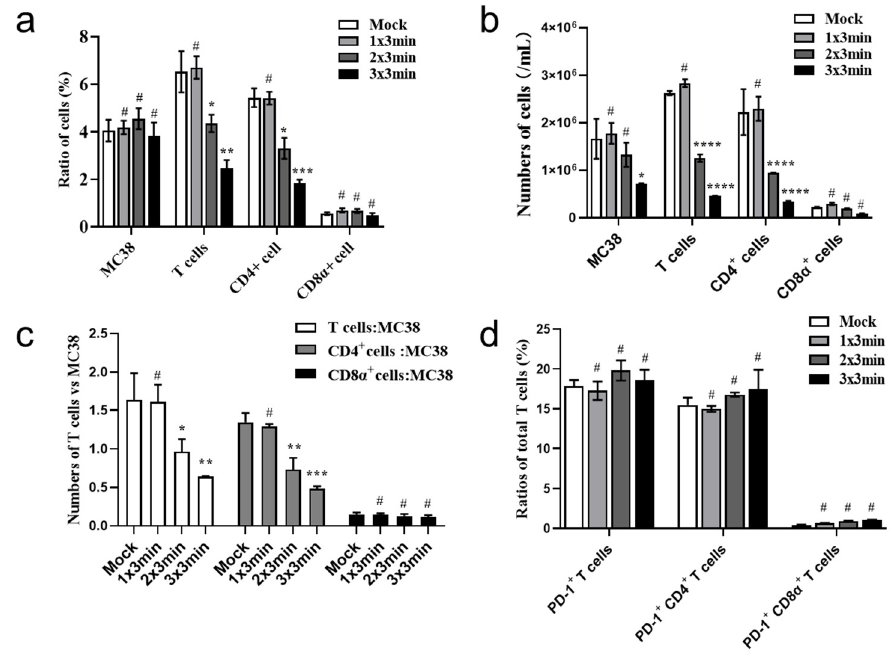
Figure 7. A high CAP treatment-generated ROS/RNS dose in vitro suppresses T cells more than tumor cells. The MC38 cells and splenic lymphocytes are cultured in DMEM containing 10% FBS, 1% penicillin-streptomycin, 3 µg/mL CD3, and 2 µg/mL CD28, and then treated with different exposure times and frequencies of CAP treatment (on-3, tw-3, and th-3), as illustrated in Figure 1a. ( b ) Flow cytometry analysis to determine the number and proportion of MC38 cells and T cell subsets in the mock and PT groups, n = 3. ( c ) Ratio of T cell subsets to MC38 cells determined based on the results in ( a , d ). Flow cytometry analysis of the proportion of PD-1 + T cell subsets in the total T cell populations, n = 3. The data are representative of three independent experiments (mean ± SD). The statistical analysis is performed using two-sided unpaired t -tests relative to the mock group (# insignificant, * p < 0.05, ** p < 0.01, *** p < 0.001, and **** p < 0.0001).